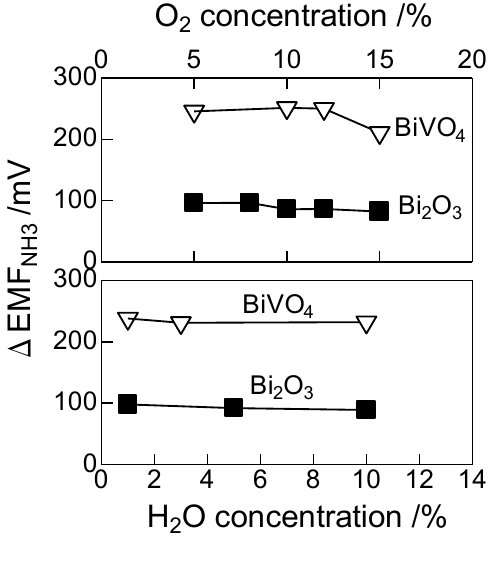
Figure 7. Influence of O BiVO (750) electrodes to 500 ppm NH 4